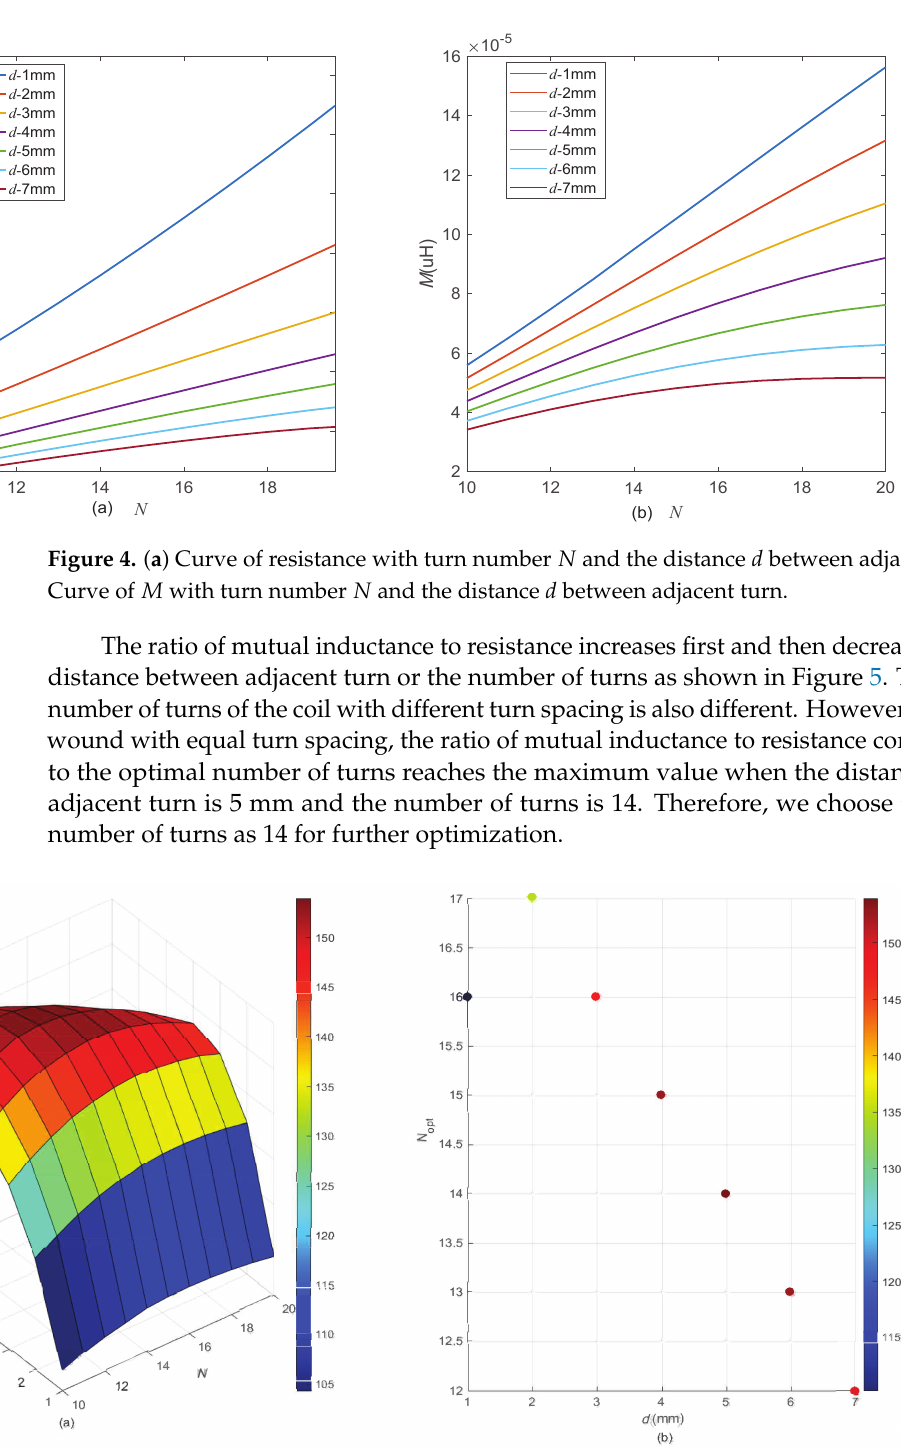
Figure 5. ( a ) Curve of transfer quality factor with turn number N and the distance d between adjacent turn. ( b ) Transfer quality factor corresponding to the optimal number of turns N opt under different turn spacing d